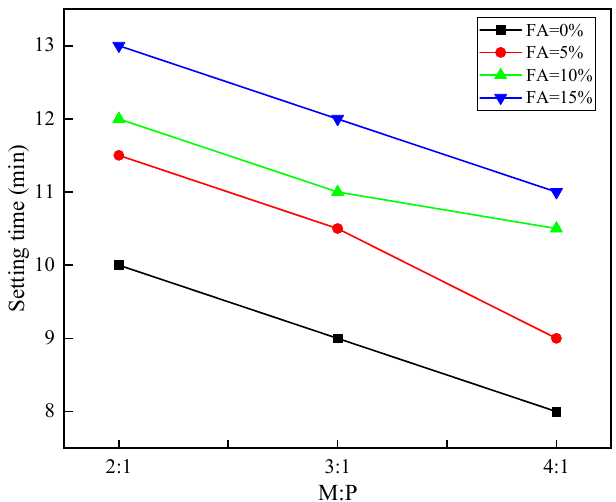
Figure 3. Setting time under different M:P.